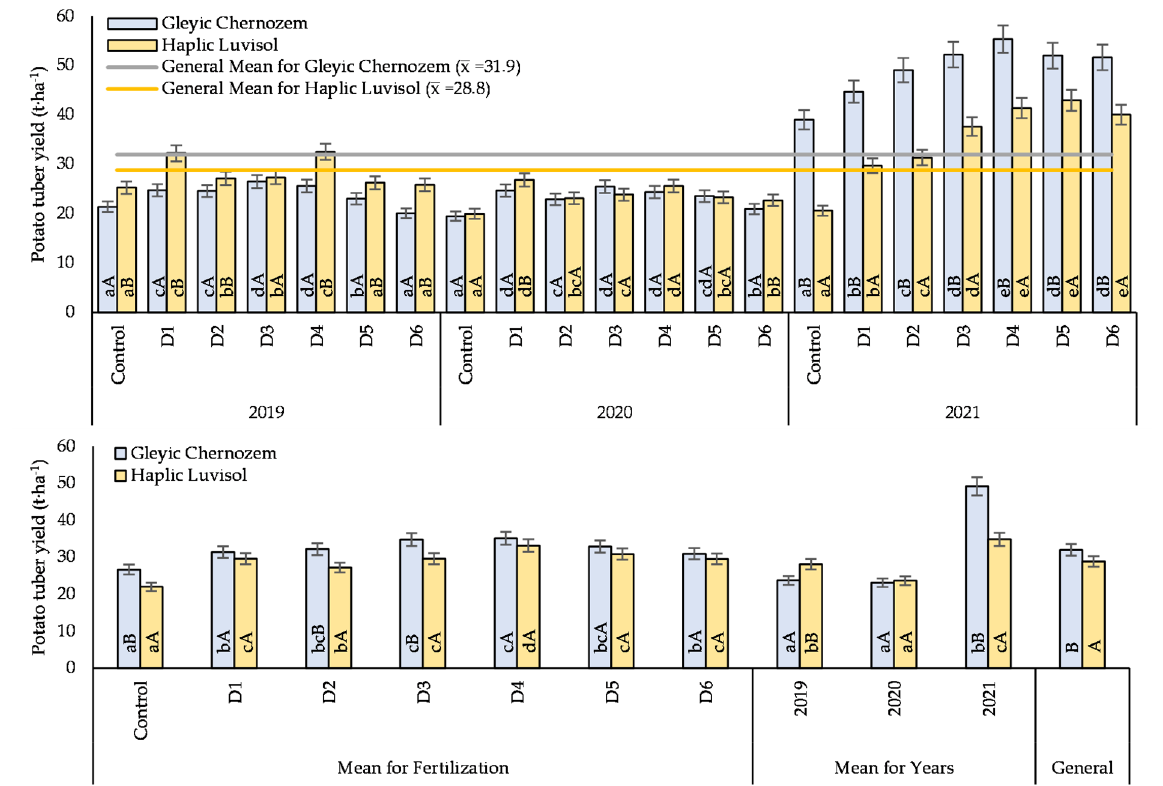
Figure 3. Average potato tuber yield (t ∙ ha − 1 ) depending on the type of soil, fertiliser applied and year of research. Statistical data are expressed as mean ± SD values. Different letters show significant differences ( p < 0.05) according to Tukey’s range test. Capital letters mean differences between particular types of soil, small letters mean differences between particular doses of fertiliser.